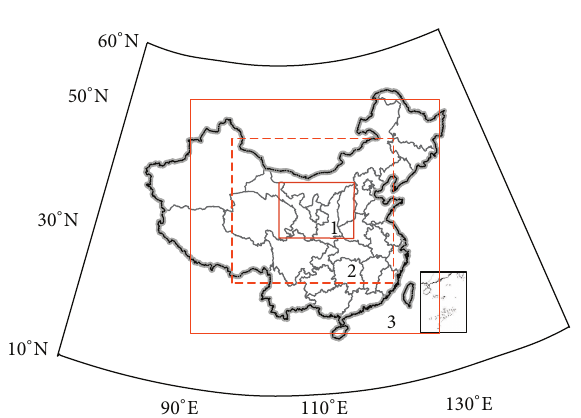
Figure 2: Schematic diagram of scheme design for three-layer nested WRF